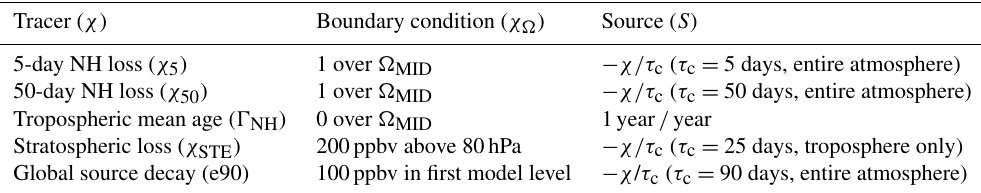
Table 2. Table of idealized tracers, χ , integrated in the simulations. All tracers ( χ ) satisfy the tracer continuity equation, (∂ t + T )χ( r ,t | (cid:127)) = S , in the interior of the atmosphere (that is, outside of (cid:127) ), where T is the linear advection–diffusion transport operator and S denotes interior sources and sinks. For the first three tracers (rows 2–4) (cid:127) is taken to be the NH midlatitude surface, (cid:127) MID , which is defined throughout as the first model level spanning latitudes between 30 and 50 ◦ N. The last two tracers, referred to throughout as the global source tracers, include the stratospheric tracer χ STE , which is set to 200ppbv for pressures less than or equal to 80hPa and decays uniformly in the troposphere at a loss rate τ d = 25days − 1 (row 5). The e90 tracer is uniformly emitted over the entire surface layer and decays exponentially at a rate of 90days − 1 such that concentrations greater than 125ppb tend to reside in the lower troposphere and concentrations less than 50ppb reside in the stratosphere (row 6).